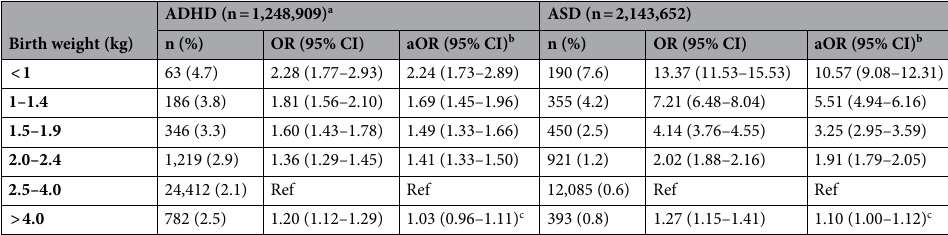
Table 2. Associations of birth weight with ADHD and ASD. ADHD attention-deficit/hyperactivity disorder, ASD autism spectrum disorder, OR odds ratio, aOR adjusted odds ratio, CI confidence interval. a The analysis of ADHD included children born between 2008 and 2010, and the analysis of ASD included children born between 2008 and 2012. b Adjusted for sex, history of congenital or perinatal diseases, income and birth year. c P ≥